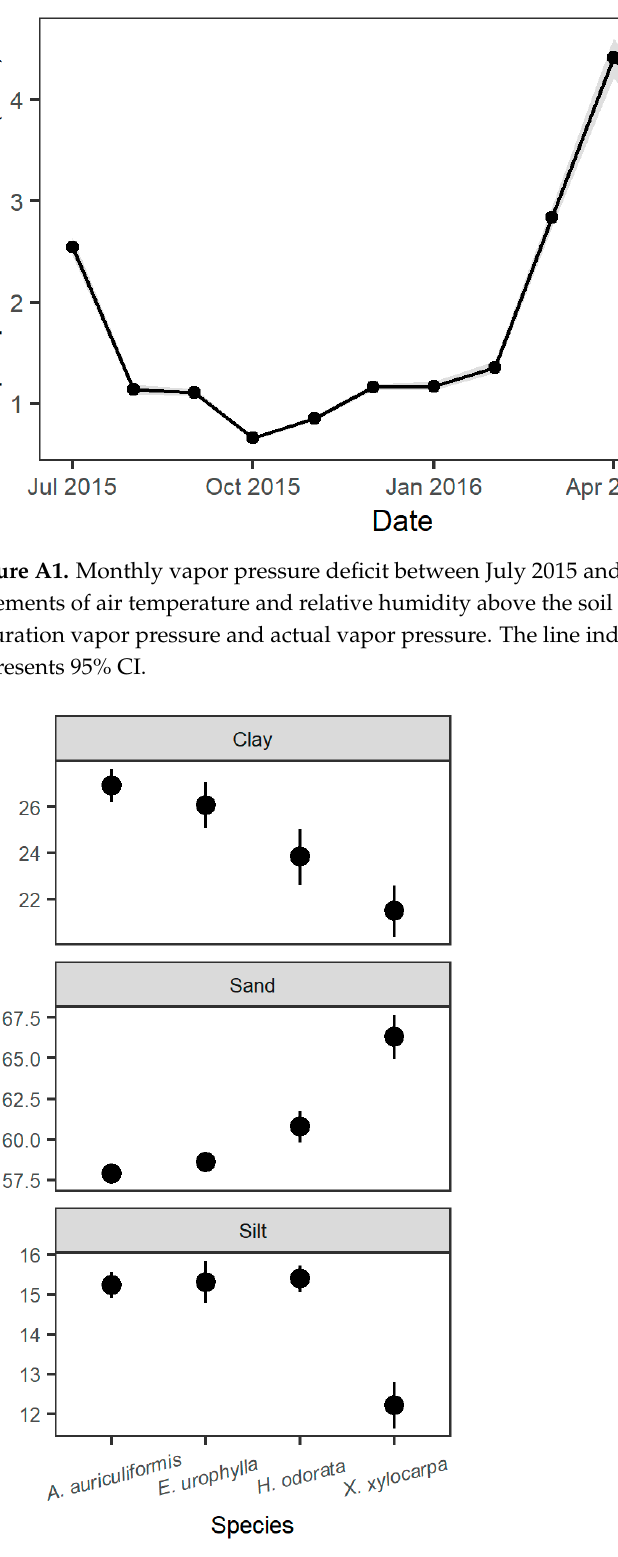
Figure A2. Distribution of soil texture in 11-year-old monospecific tree plantations in tropical forest soils. The graph displays the mean and standard deviation of soil texture components—sand, silt, and clay—across each species. Table A1. Mean and standard deviation of soil properties by type and depth in four plantation plots. Soil properties include physical properties (sand (%), silt (%), and clay (%)), chemical properties (carbon (%), nitrogen (%), pH, and soil organic matter (%)), and nutrient properties (exchangeable cations of calcium (mg kg − 1 ), magnesium (mg kg − 1 ), potassium (mg kg − 1 ), and phosphorus (mg kg − 1 ), which were determined following the methods described by [68–70]). Soil MAXIAOYU- Characteristic